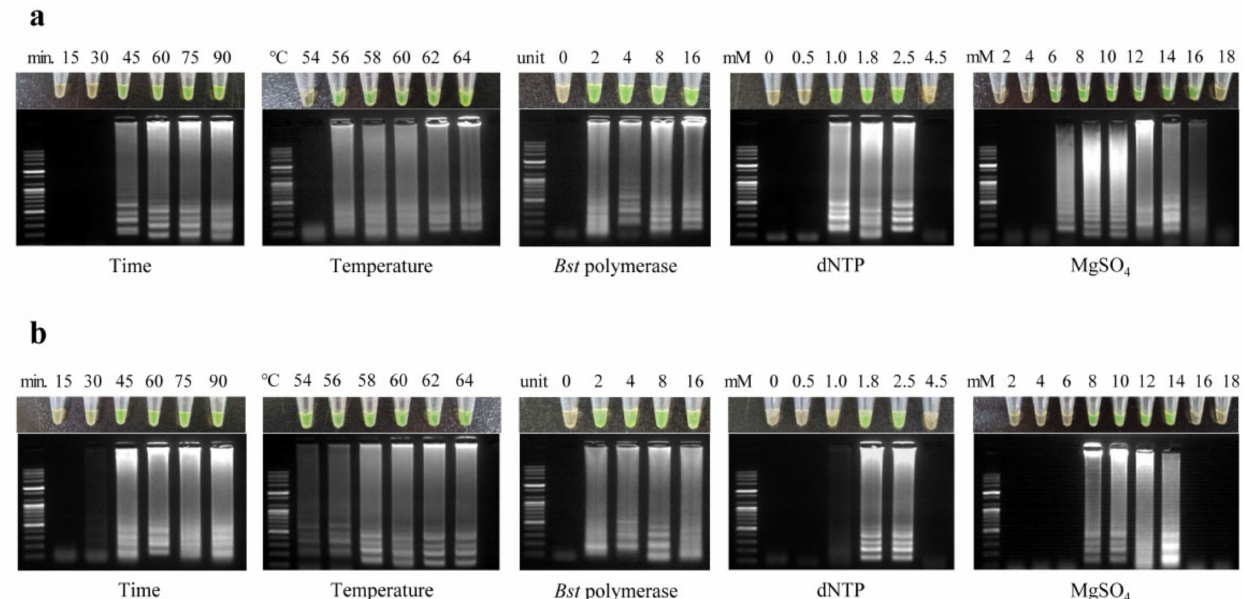
Figure 3. Optimization of the loop-mediated isothermal amplification (LAMP) assay. LAMP reactions were performed with different reaction times (15–90 min), temperatures (54–64 ◦ C), concentrations of Bst DNA polymerase (0–16 unit), dNTP (0–4.5 mM), and MgSO 4 (2–18 mM). ( a ) Ostreopsis cf. ovata. ( b ) Amphidinium massartii